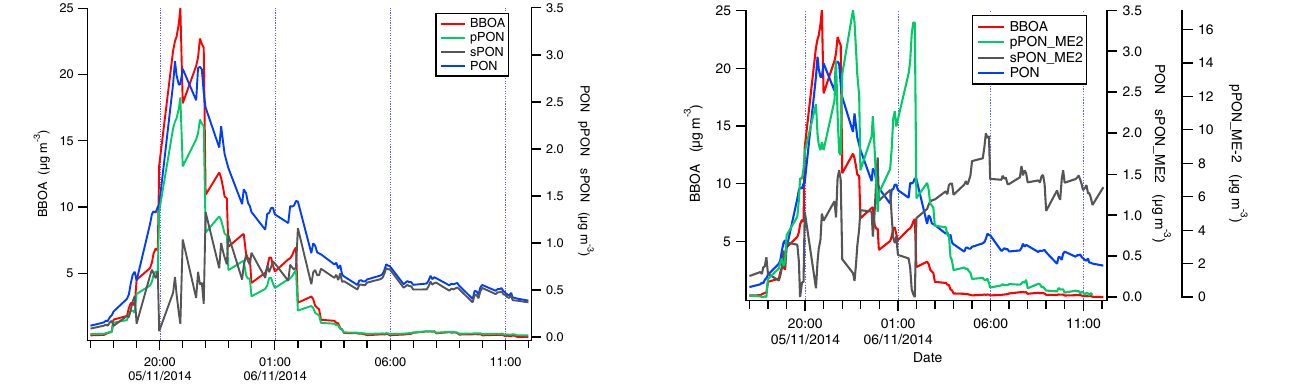
Figure 7. Secondary and primary organic nitrate time series ob- tained from ME-2 analysis.